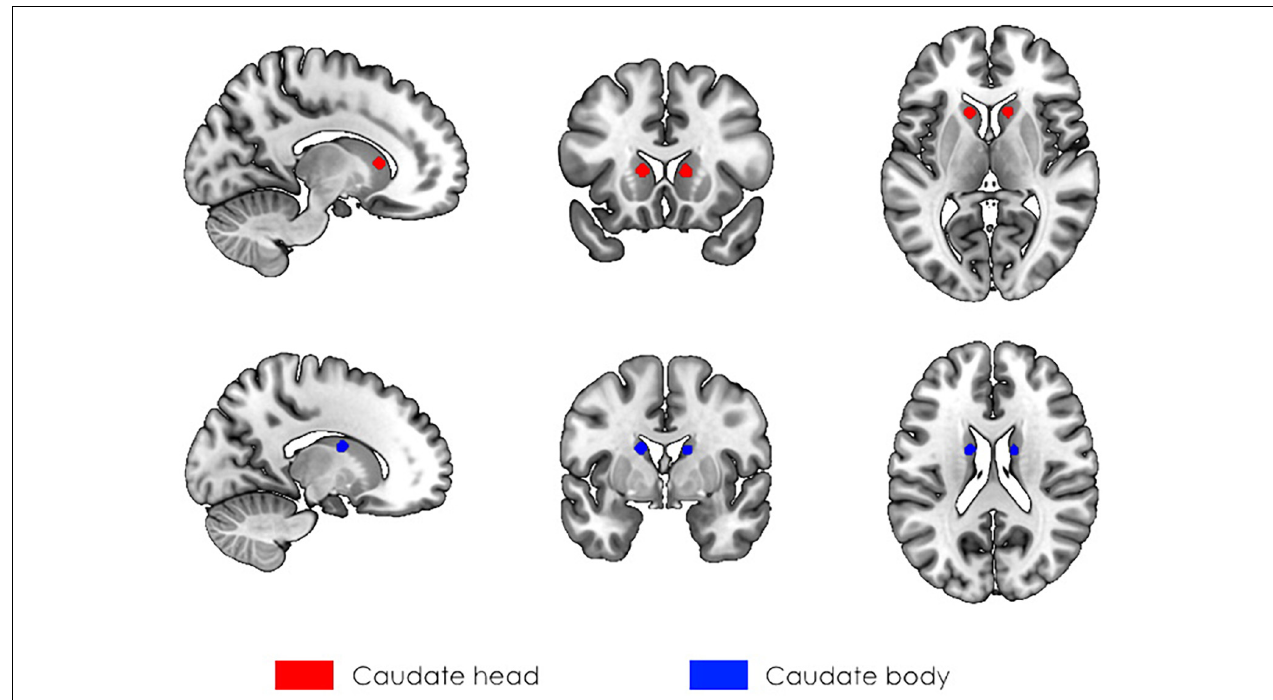
FIGURE 1 | The localization of seeds used in the analysis of rs-fMRI. The 5 mm spherical masks were created for the head (red, seeds No. 1, and No. 3) and body (blue, seeds No. 2, and No. 4) of the caudate bilaterally according to Seitzman et al.